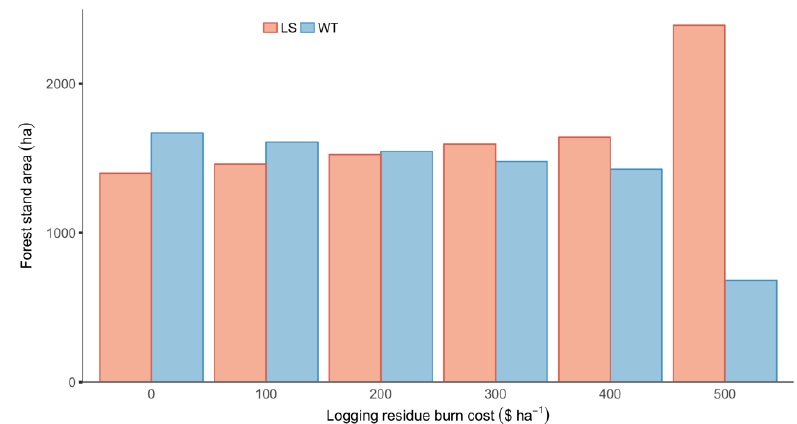
Figure 7. Effects of logging residue disposal costs on economically preferred harvesting method between lop and scatter (LS) and whole-tree harvesting (WT) in the lodgepole pine stands of the Colorado State Forest State Park.